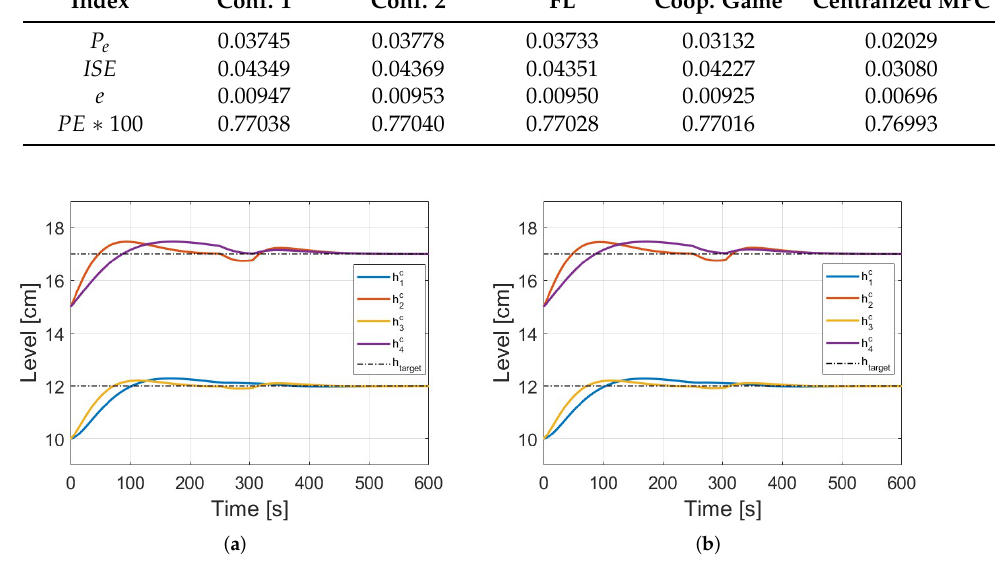
Figure 7. Validation Case 2: Evolution of the levels of the controlled variables involving disturbance